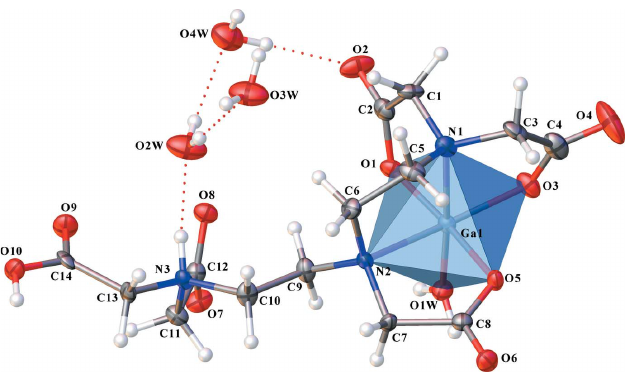
Figure 3 A packing diagram of the title compound, viewed along the b axis. Dashed lines show O—H (cid:2)(cid:2)(cid:2) O, N—H (cid:2)(cid:2)(cid:2) O and C—H (cid:2)(cid:2)(cid:2) O hydrogen